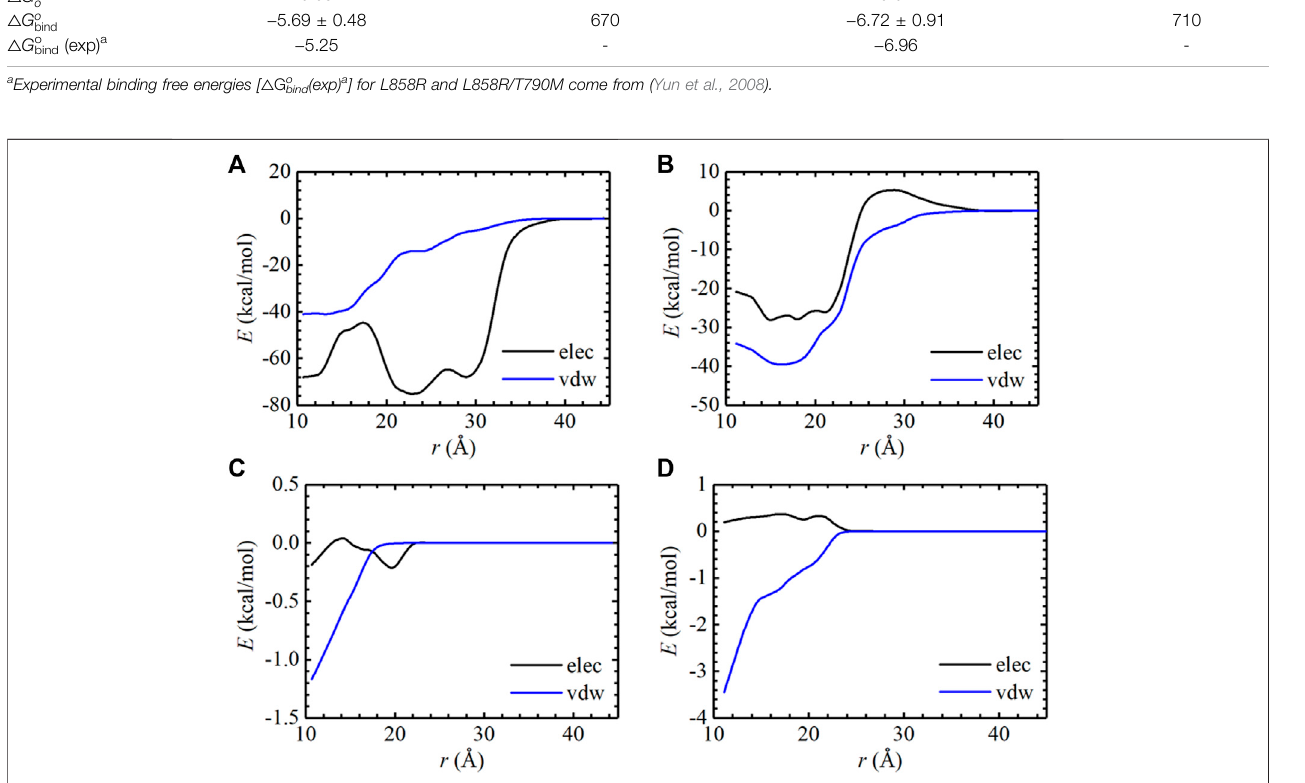
FIGURE2| PairinteractionenergyfortheseparationoftheL858Rmutant:AMP (A) andtheL858R/T790Mmutant:AMP (B) weredecoupledintoelectrostaticand van der Waals contributions. The pair interaction energy for the separation of the Thr790 residue: AMP (C) and the Met790 residue: AMP (D) were decoupled into electrostatic and van der Waals